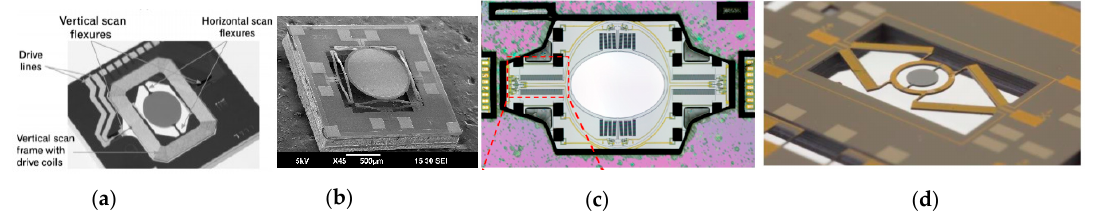
Figure 15. High-FoM 2D quasi-static and resonant scanning MEMS mirrors with ( a ) electromagnetic actuators [80]; ( b ) electrothermal actuators [109]; ( c ) electrostatic actuators [112]; ( d ) piezoelectric actuators [87].